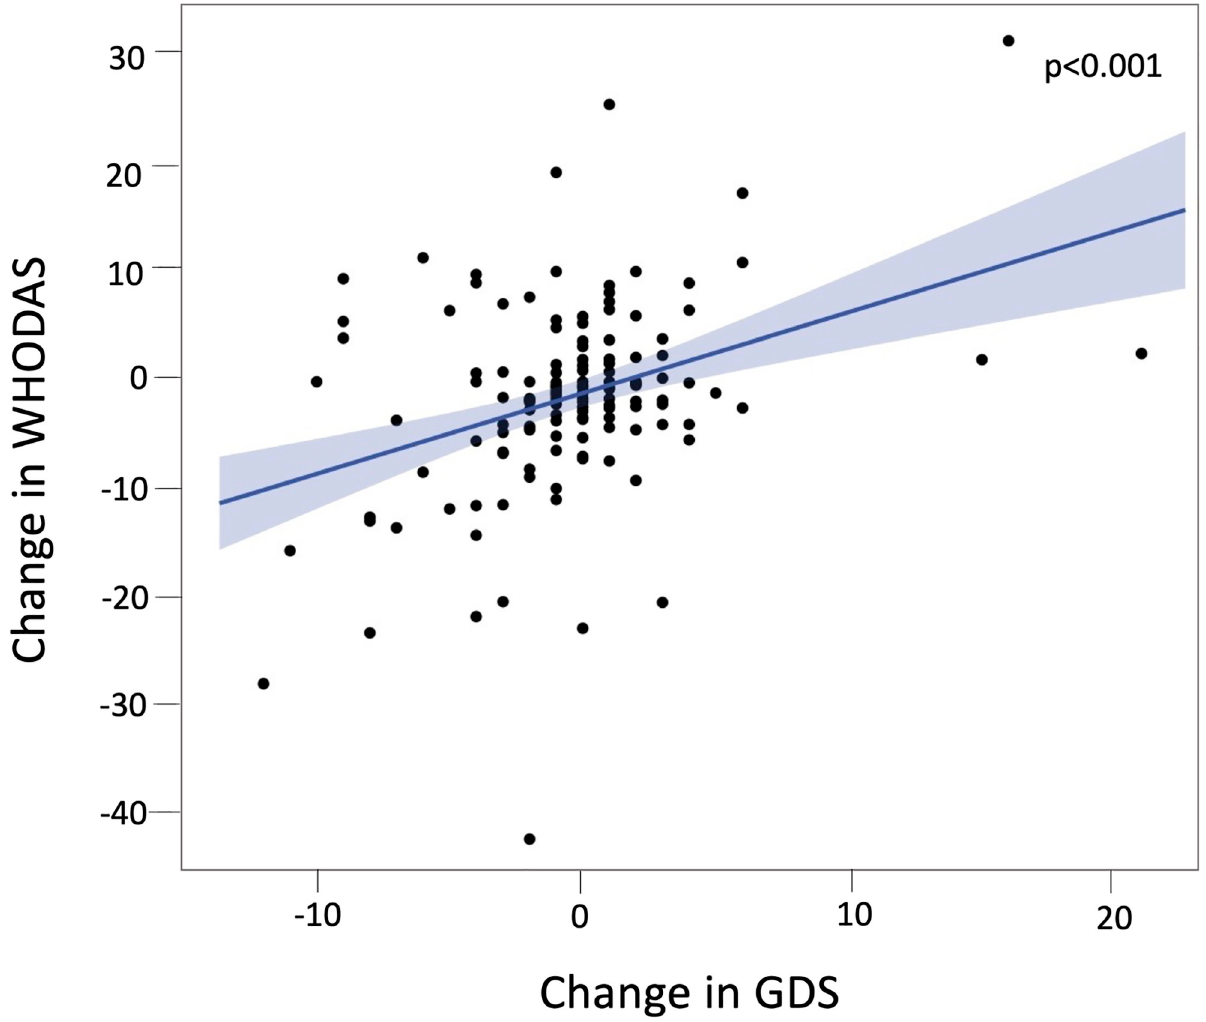
Fig 3. Change in depressive symptoms predicts change in disability over 48 weeks. Worsening depressive symptoms on GDS (baseline to Mid- Study) were related to increasing disability on WHODAS (baseline to week 48) ( p < 0.001). Forty-six participants experienced worsening of both GDS and WHODAS, while 24 participants experienced improvement on both measures. A 10-point increase in GDS corresponds to conversion from no depression to mild depression. WHODAS 2.0 Complex score ranges from 0 to 100, with each 10-point increasing corresponding to a 10% increase in overall